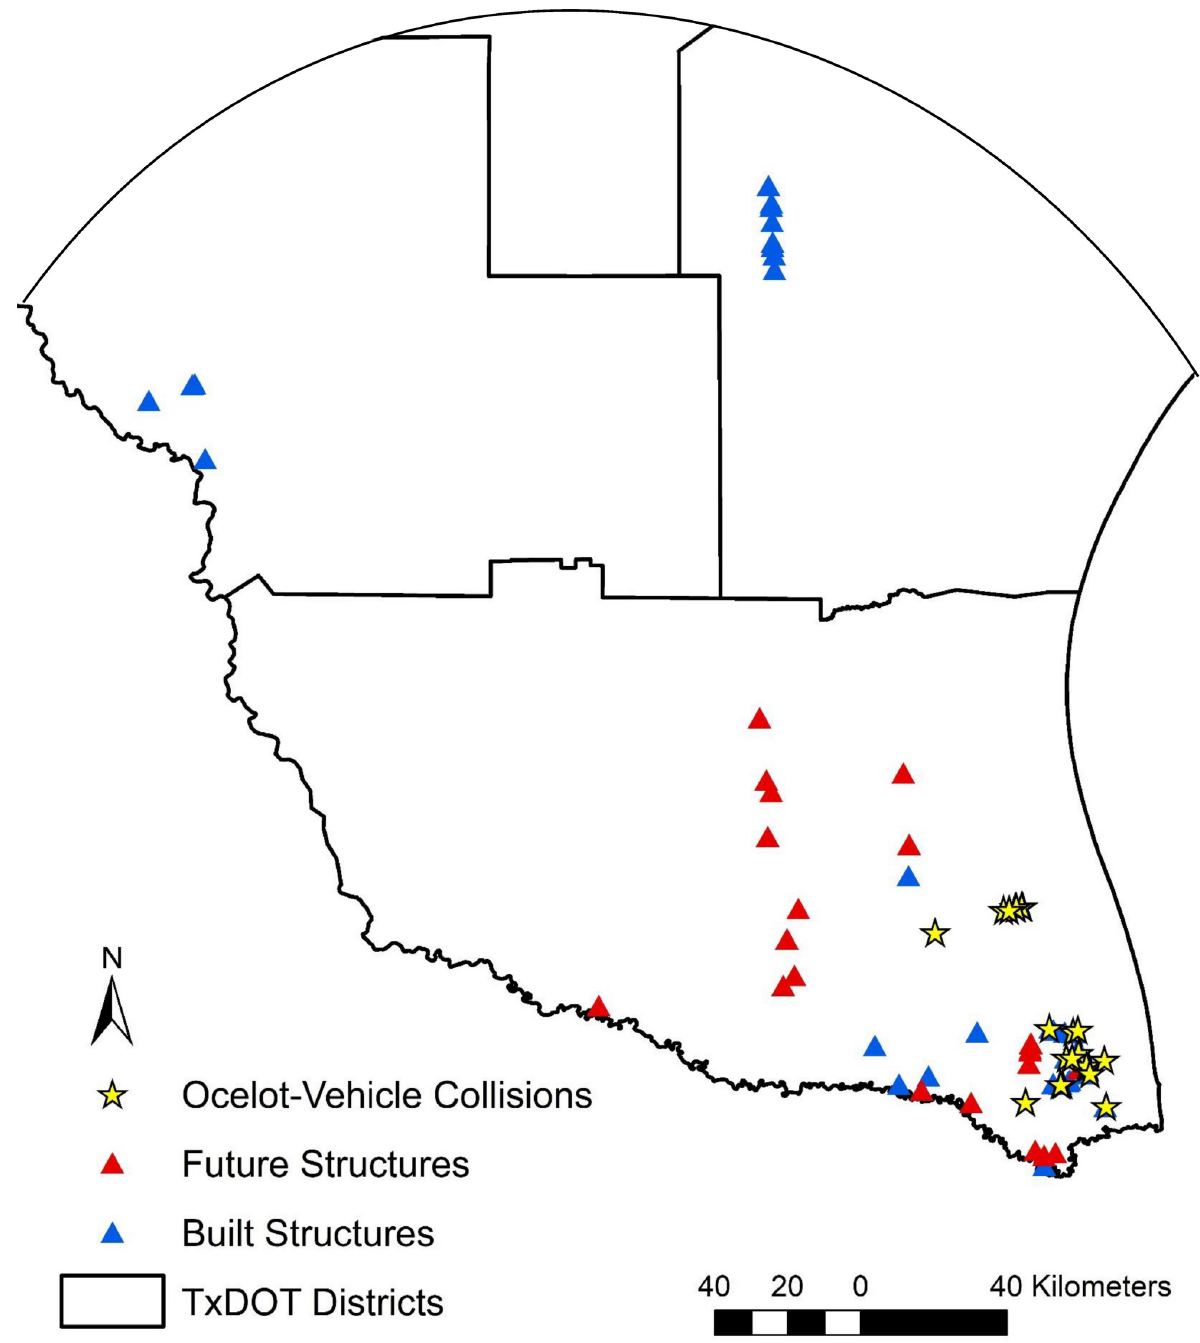
Fig 2. Locations of 26 ocelot-vehicle collisions (stars) and ocelot road crossing structures (triangles) in the Pharr district. Boundary data from TxDOT Open Data Portal, original copyright 2018.